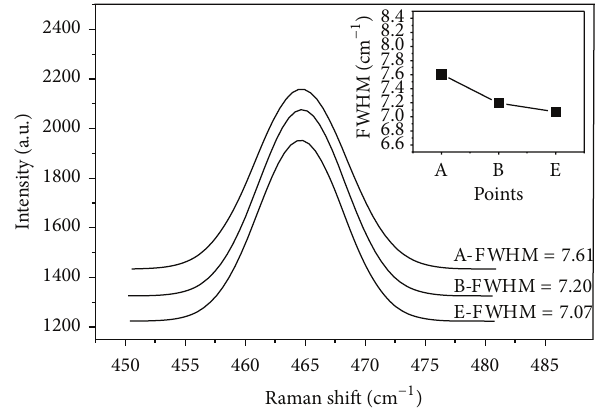
Figure 17: Gaussian fitting to characteristic Raman shift of quartz in siliceous rock from Bafangshan-Erlihe area. Figure 18: Gaussian fitting to a characteristic Raman shift for siliceous rock of the Bafangshan-Erlihe